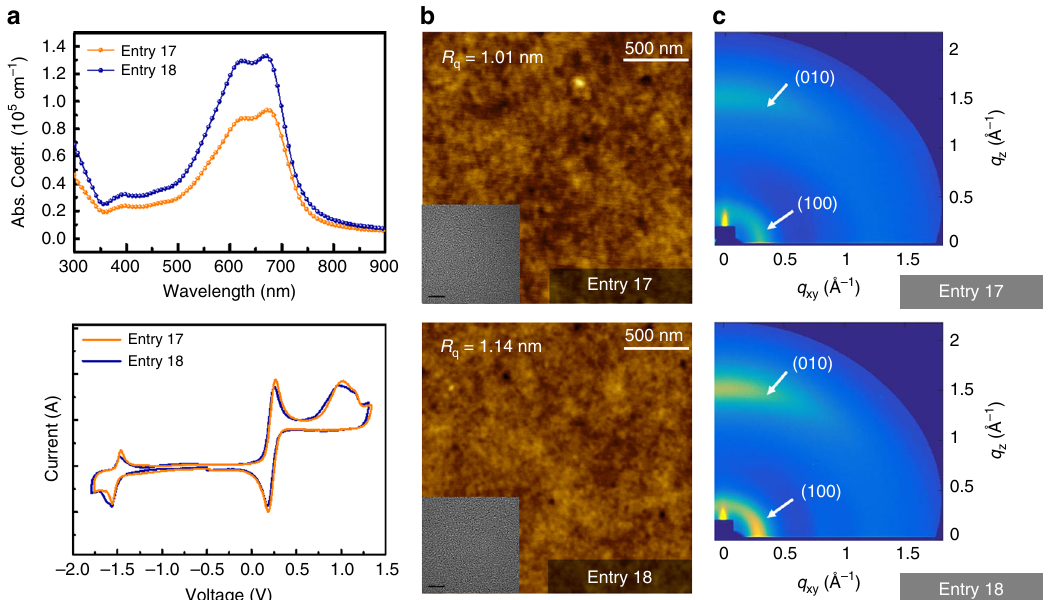
Fig. 2 Optical, electrochemical, and morphological properties of entries 17 and 18. a UV – Vis absorption spectra and cyclic voltammograms. b AFM height images in a scale of 500 nm with inset TEM images (5 nm scale). c GIWAXD images of in-plane and